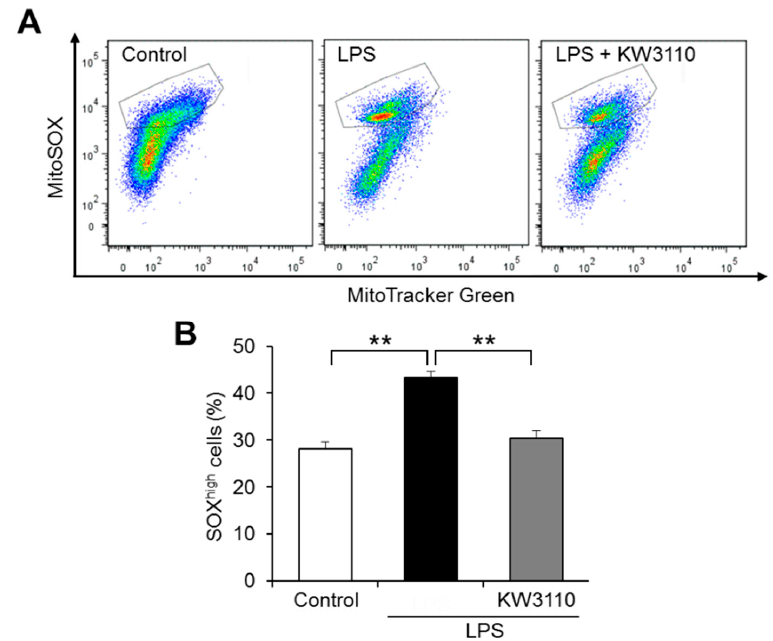
Figure 2. KW3110 treatment decreases mitochondrial ROS production in LPS-stimulated J774A.1 cells. Mitochondrial ROS production was analyzed in J774A.1 cells labeled with MitoTracker Green (100 nM) and MitoSOX (5 μ M). Cells were treated with KW3110 (1 μ g/mL) for 24 h, followed by stimulation with LPS (0.1 μ g/mL) for 24 h. ( A ) Representative flow cytometry plots of labeled cells. The plots surrounded by gray lines represent cells with higher MitoSOX intensity than MitoTracker Green intensity (SOX high cells). ( B ) The ratio of SOX high cells to total cells was calculated. Values represent the means ± SEM. n = 3. Statistical differences were analyzed by ANOVA followed by Tukey’s test. ** p < 0.01.